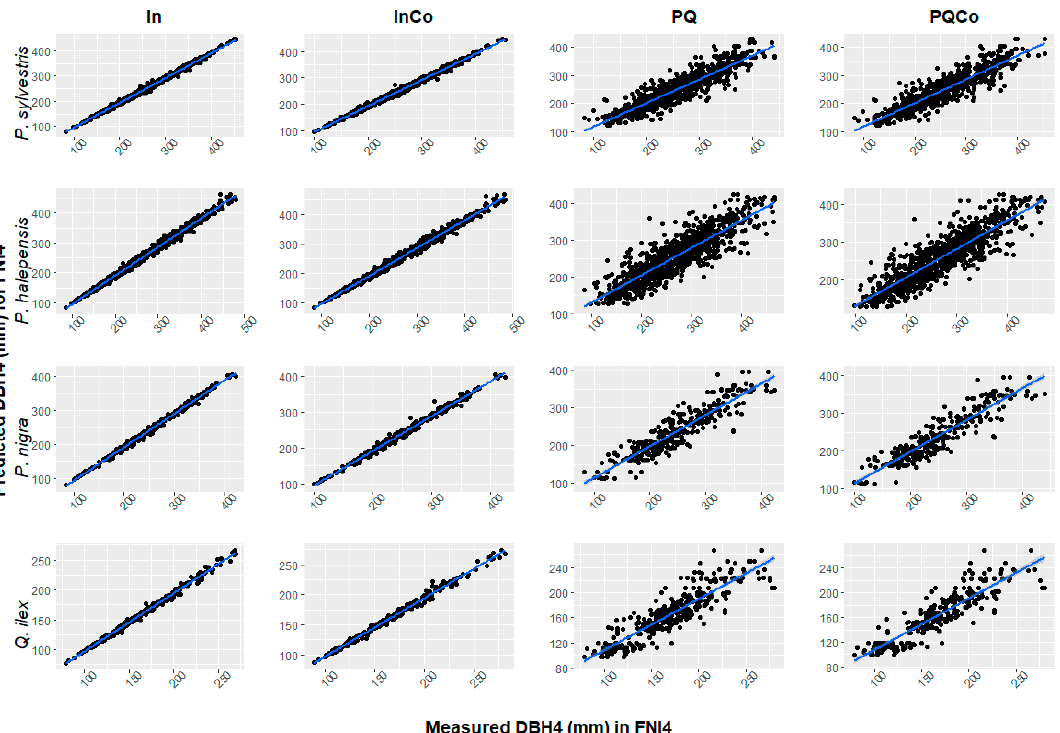
Figure 2. Linear regression line of observed and expected DBH in the fourth National Forest Inventory (DBH4, mm). We considered two aggregation levels (individual and plot-quantile classes), two Equations (1) and (2), and four species ( Pinus sylvestris , P. halepensis , P. nigra , and Quercus ilex ). For the plot quantile aggregation level, the median observed DBH4 was considered for each quantile-plot class instead of the individual observed DBH4. Table 2. Determination coefficient r 2 was calculated over observed vs. expected DBH for each considered aggregation level (individual (In) and plot-quantile classes (PQ)), Equations (1) and (2) (Co for competition), and species (rows: Pinus sylvestris , P. halepensis , P. nigra , and Quercus ilex ).